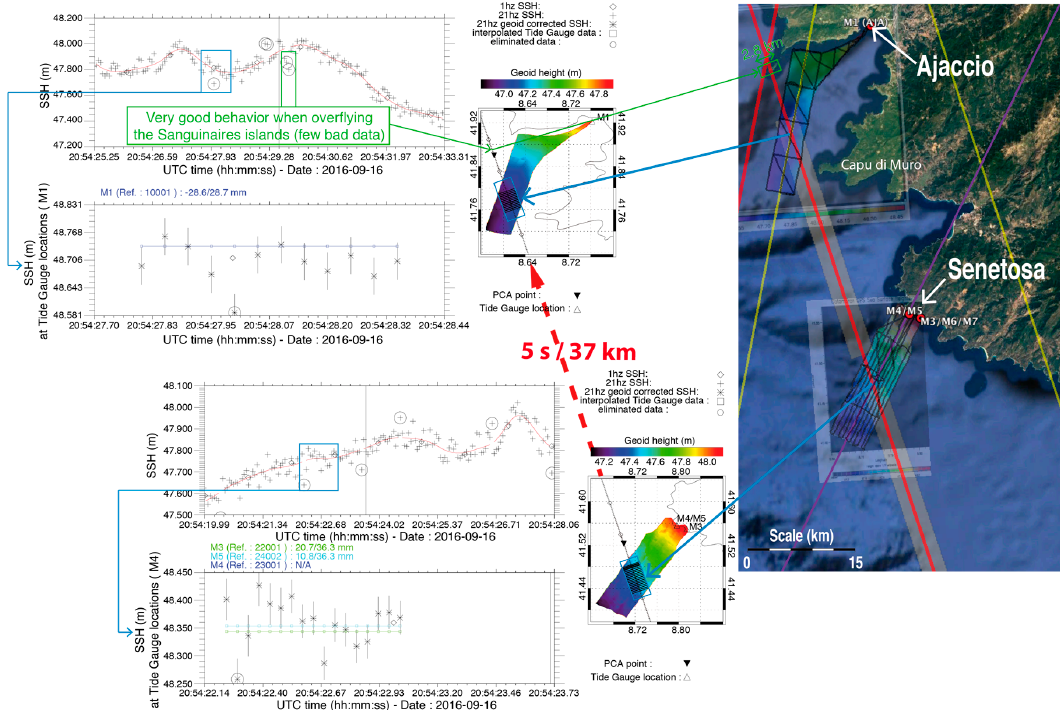
Figure 5. Example of sea surface height (SSH) bias processing for Sentinel-3A in synthetic aperture radar (SAR) mode (pass 741, cycle 8). For each independent processing (Ajaccio, top/Senetosa, bottom) the upper plot shows ±4 s of altimeter SSH series around the point of closest approach (PCA). The lower plots show the selected SSH (inside the geoid area) that are corrected from the geoid height differences between the SSH location and the tide gauge locations.